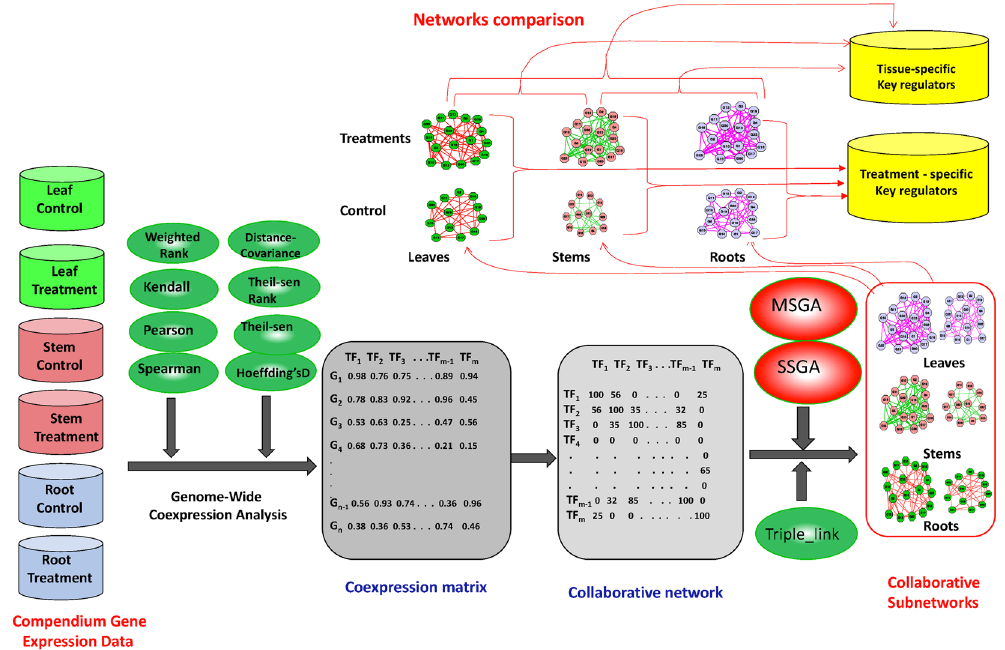
Figure 1. The illustration of a framework in which SSGA and MSGA are used to construct collaborative regulatory gene subnetworks, each governing a biological process or a complex trait. Multiple collaborative subnetworks can be constructed using data from different cell/tissue types or treatment conditions, and the resulting subnetworks can be compared for pattern recognition of key regulatory gene sets for specific treatment conditions or tissue/cell